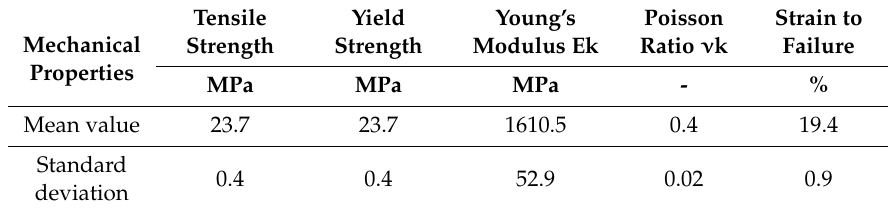
Figure 14. Stress diagram as a function of strain of the Plexus MA300 methacrylic adhesive. Table 3. Mechanical properties determined for the tested Table 3. Mechanical properties determined for the tested adhesives.